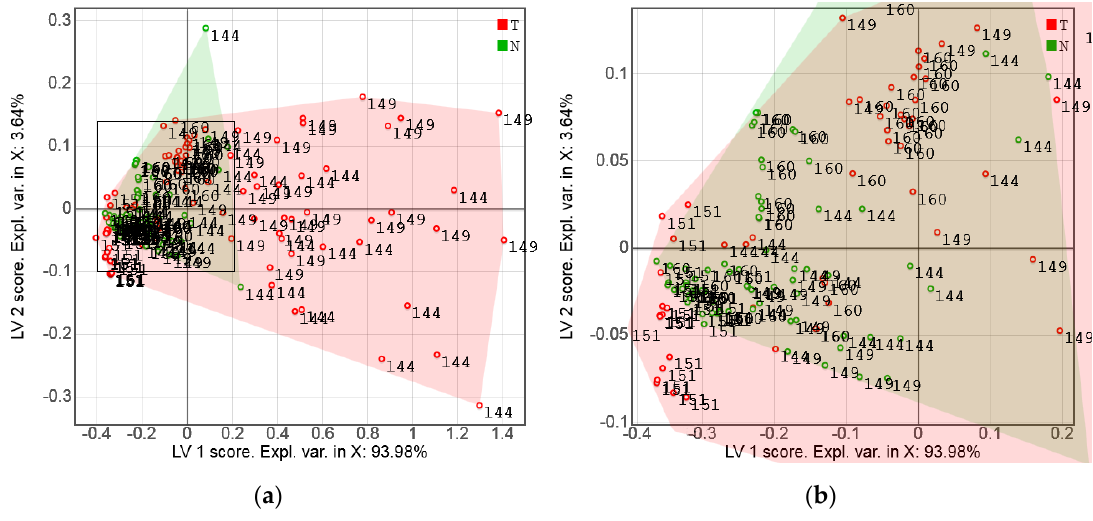
Figure 9. Score plot of the first two latent variables (LV2 vs LV1) for a principal component analysis (PCA) model for the sensor data of Series B: ( a ) full area, and ( b ) magnification of selected area in ( a ). Tumor and normal tissue measurements are shown with red and green markers, respectively. The numbers designate patient IDs.